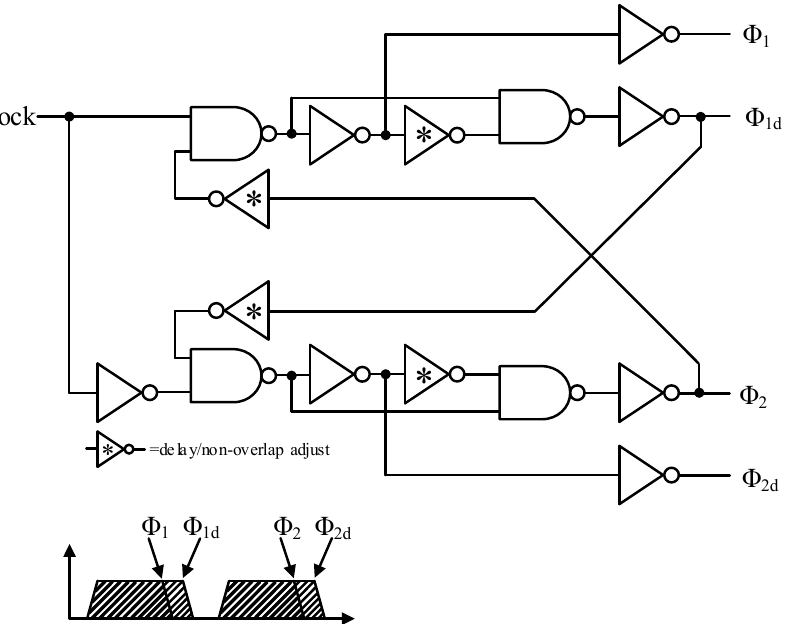
Figure 9. A schematic of the clock generator.